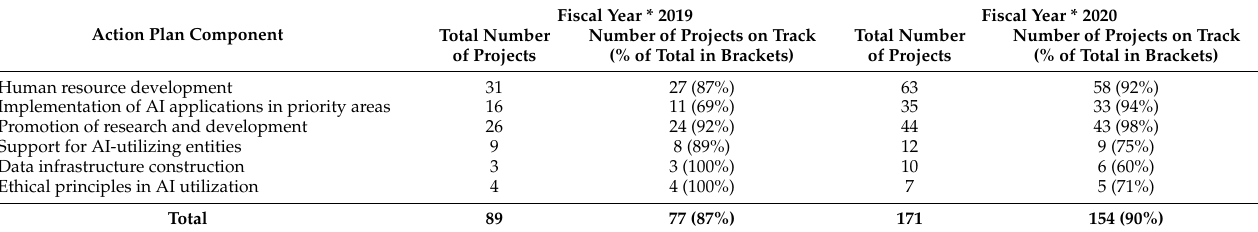
Table 1. Implementation status of the AI